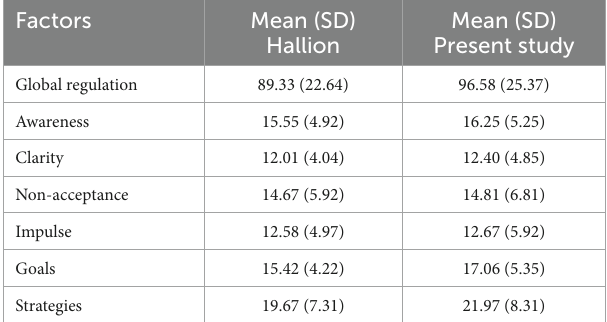
TABLE 8 Means and standard deviations for each dimension of emotional regulation in the clinical sample ( n = 427) and the present study ( n =